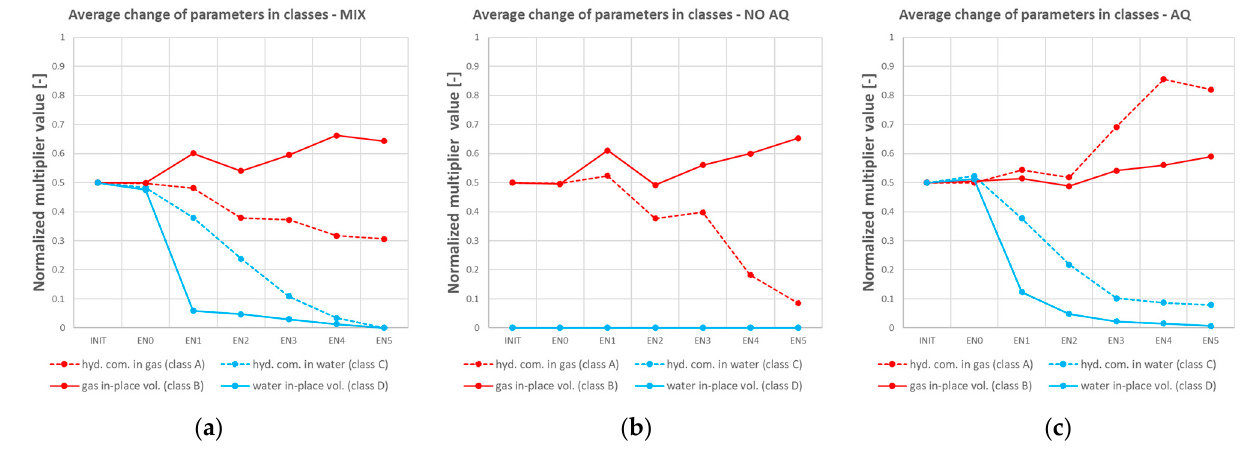
Figure 11. The average change of parameters during the history-matching, various aquifer scenarios—calibration using two years of production data. ( a ) Acenario mix; ( b ) no aquifer; ( c ) aquifer.